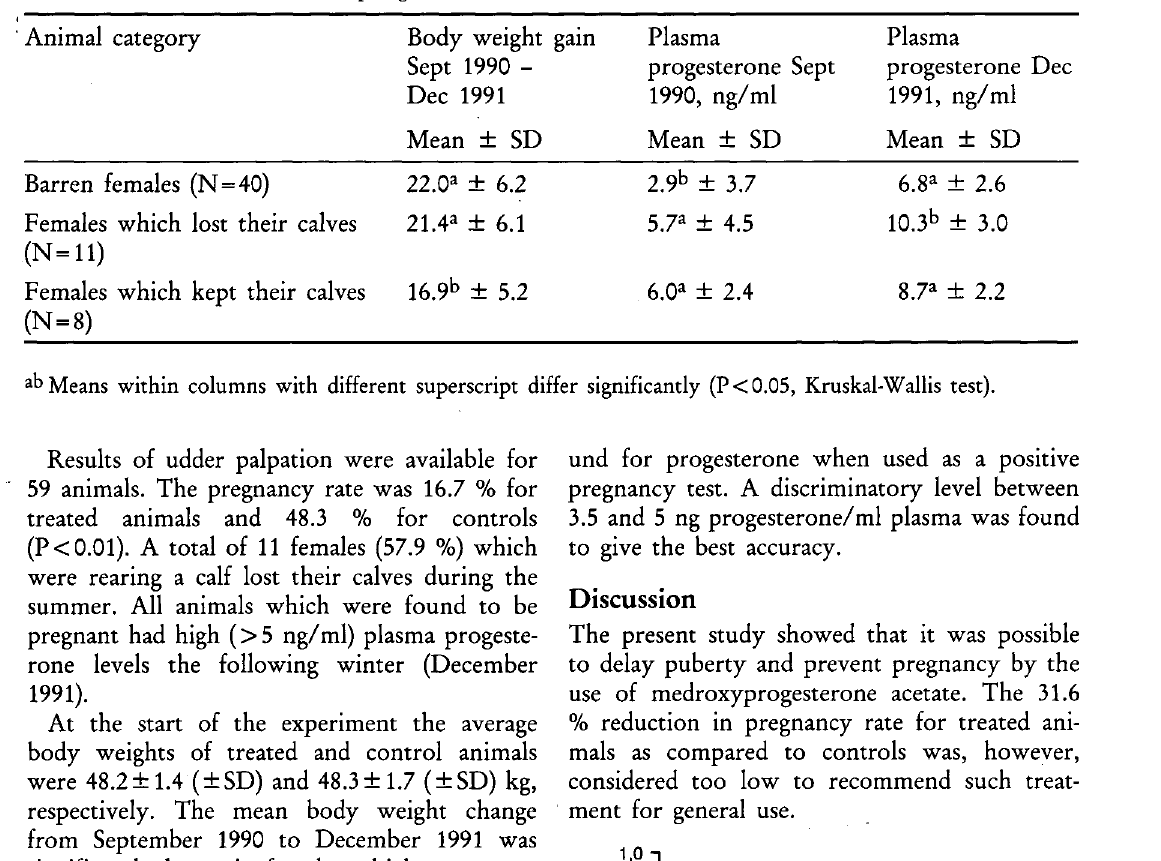
• Table 1. Body weight increases and plasma progesterone values in reindeer claves as related to pregnancy status and fate of the offspring.